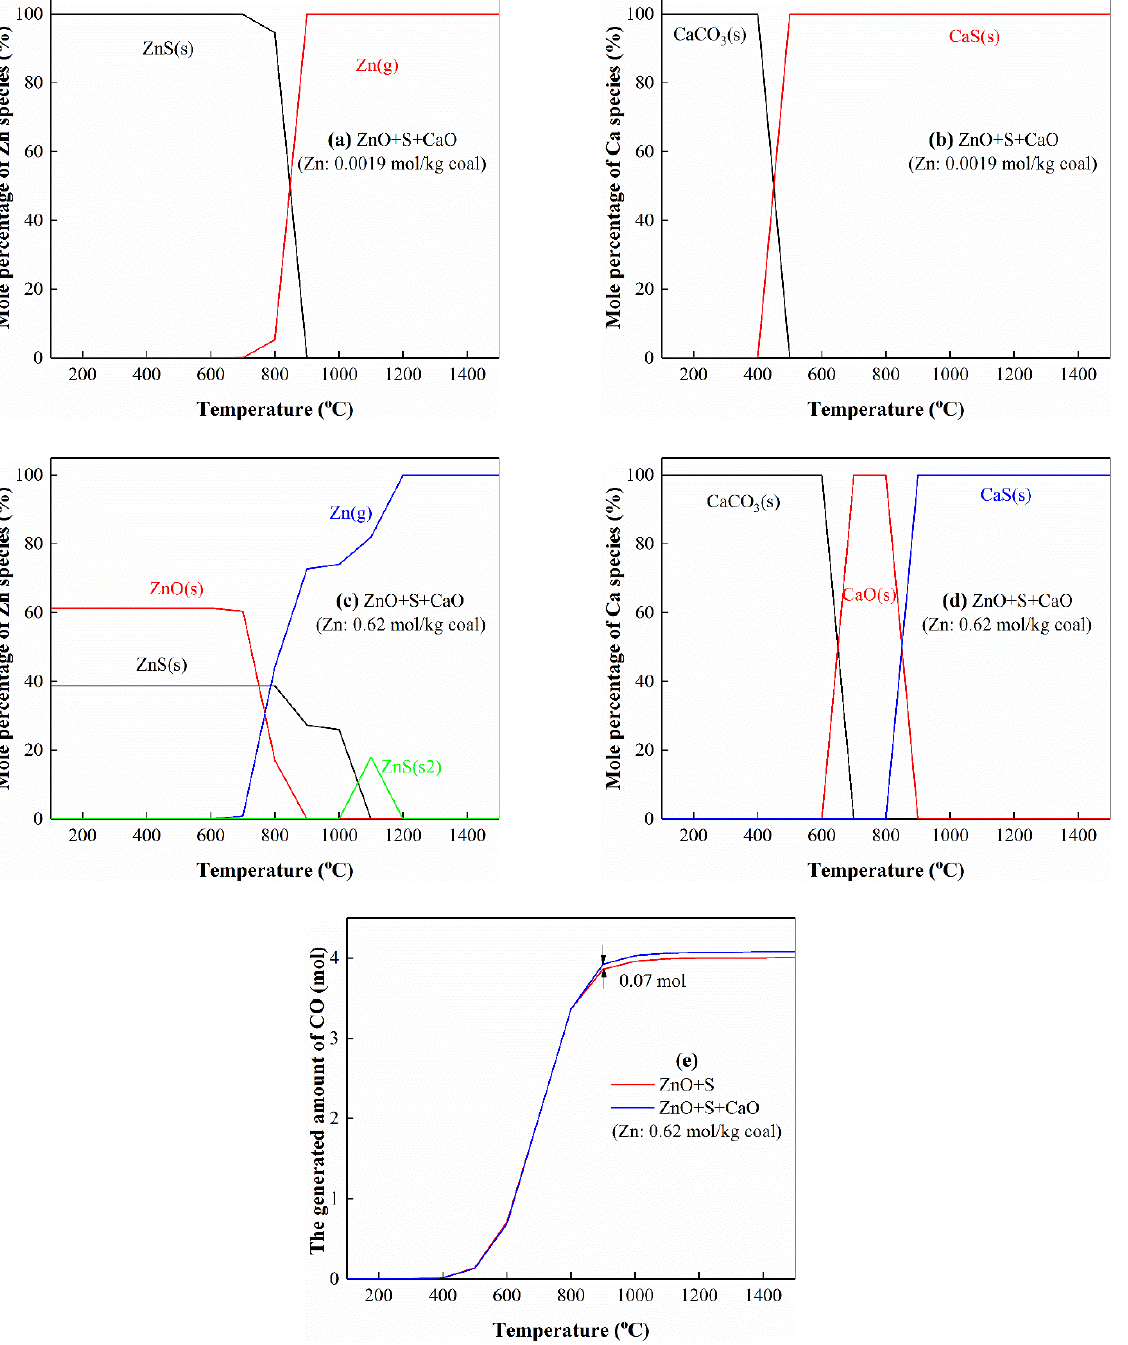
Figure 8. The thermodynamic equilibrium distributions of Zn ( a , c ), Ca ( b , d ) and generated amount of CO ( e ) when S, Zn and Ca coexist in the